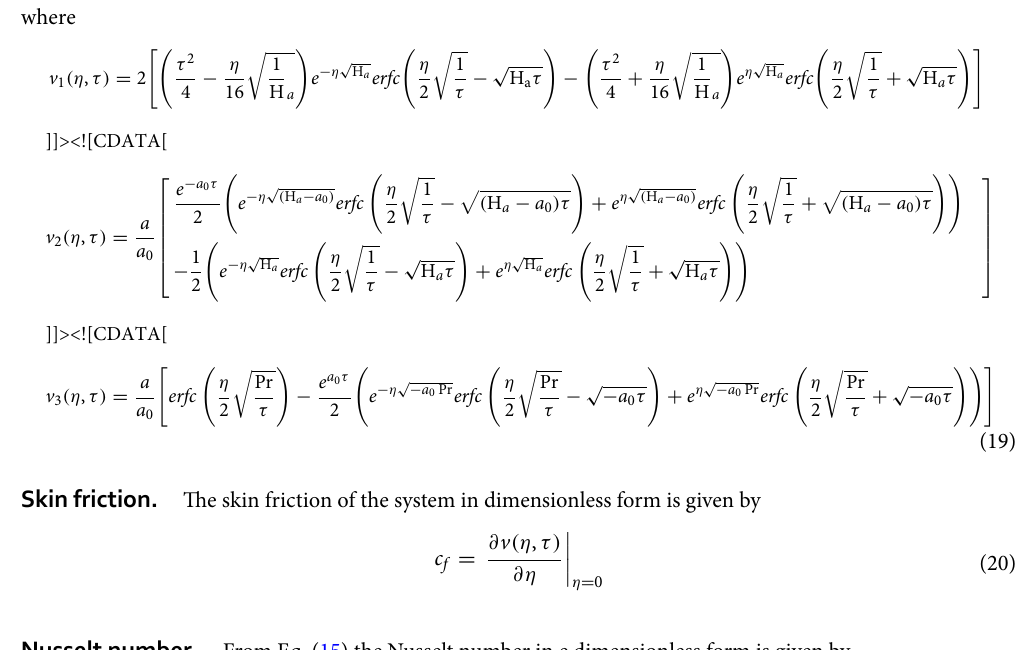
Nusselt number. From Eq. (15) the Nusselt number in e dimensionless form is given